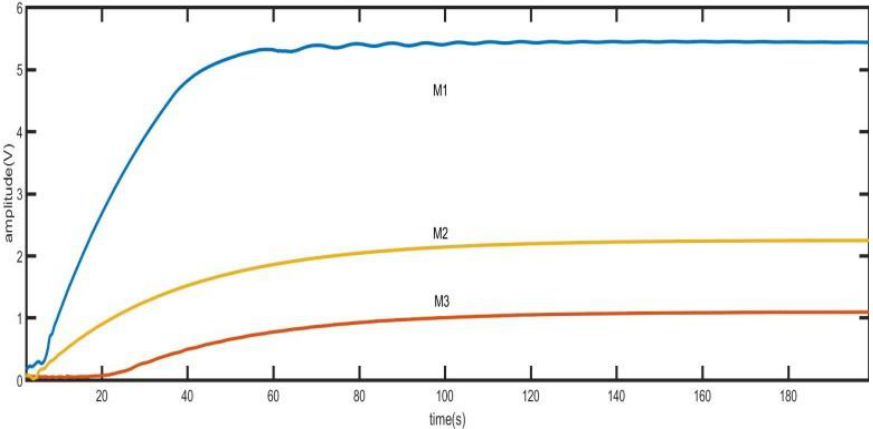
Figure 6. The time of step